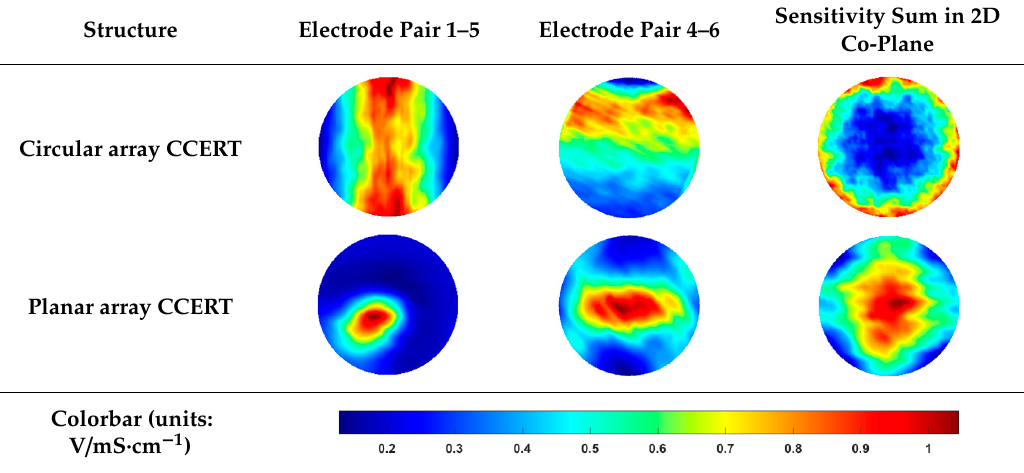
Table 1. The sensitivity distribution of the electrode pair 1–5 and 4–6, and the sensitivity sum in 2D co-plane for circular array CCERT and planar array CCERT.